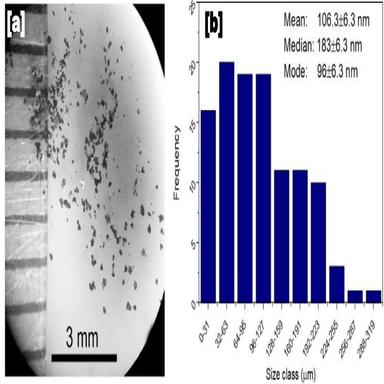
(a) Optical stereomicroscopy (magnification 20x) and (b) size distribution for a sonicated sample of ZVS